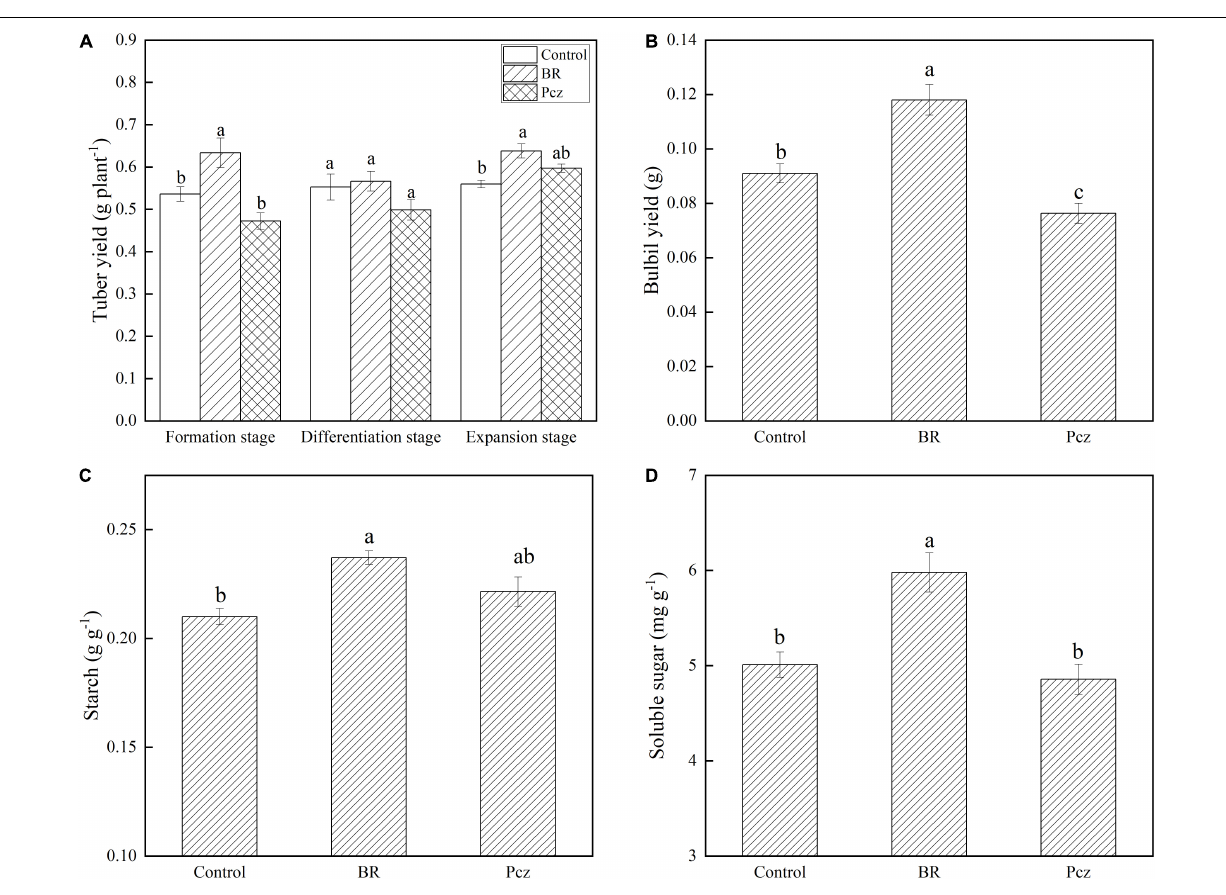
expansion stages, compared to the control, respectively. The F v /F m value was increased by 8.40, 7.41, and 7.88% under BR treatment at formation, differentiation, and